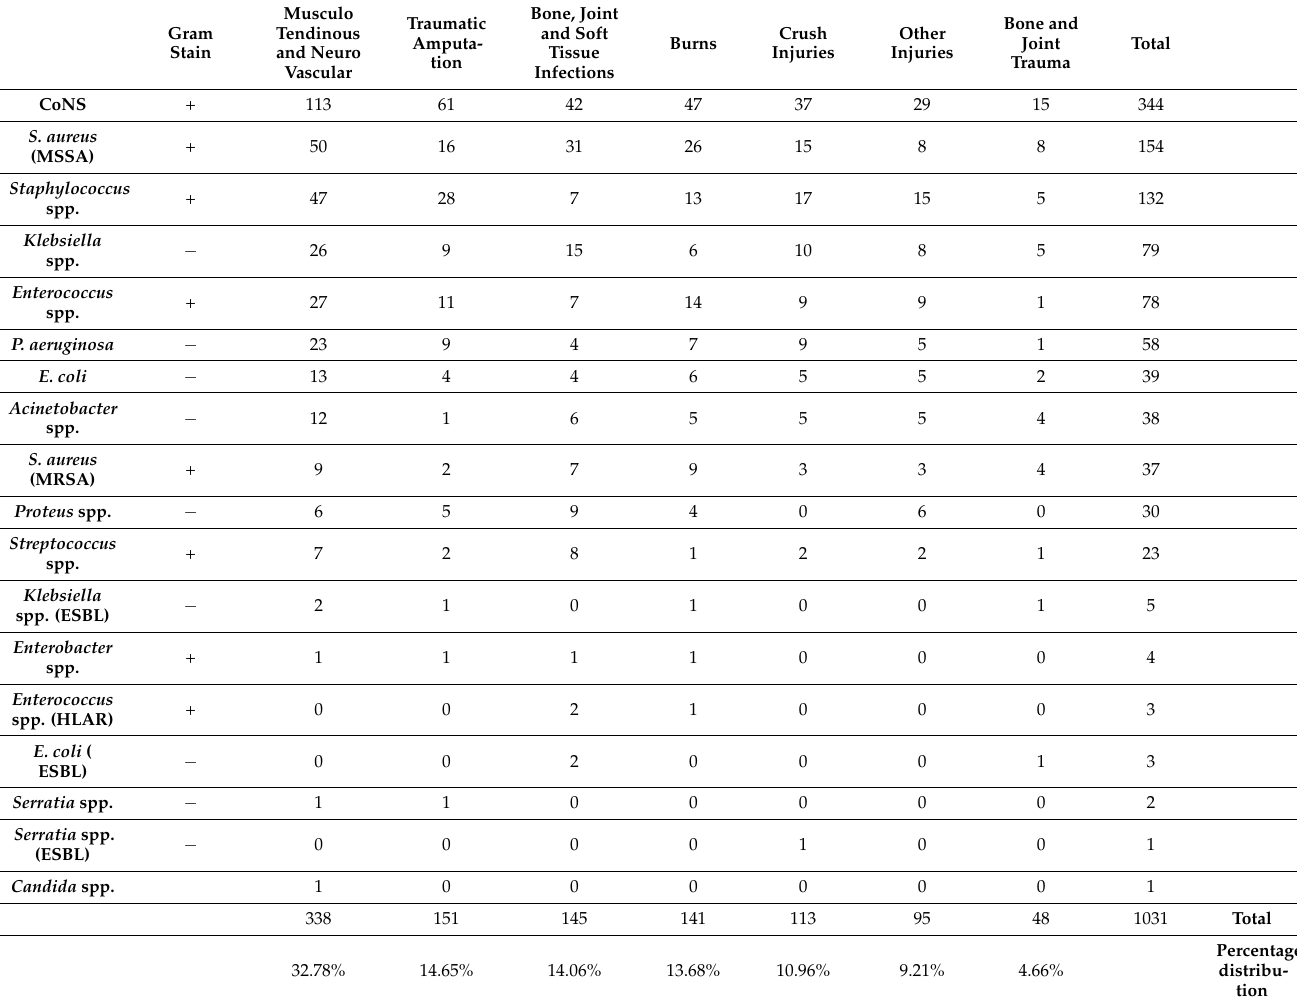
Table 3. Correlation between diagnosis and germs at admission.